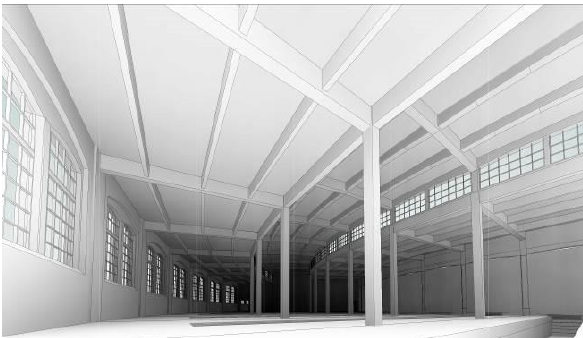
Figure 10. Internal perspective view of Smistamento Roundhouse Finally, in order to check the geometric accuracy of the virtual model, a comparison between the used point cloud and the parametric achieved model has been performed, using the tool available in the used PointSense plug-in (Figure 11).